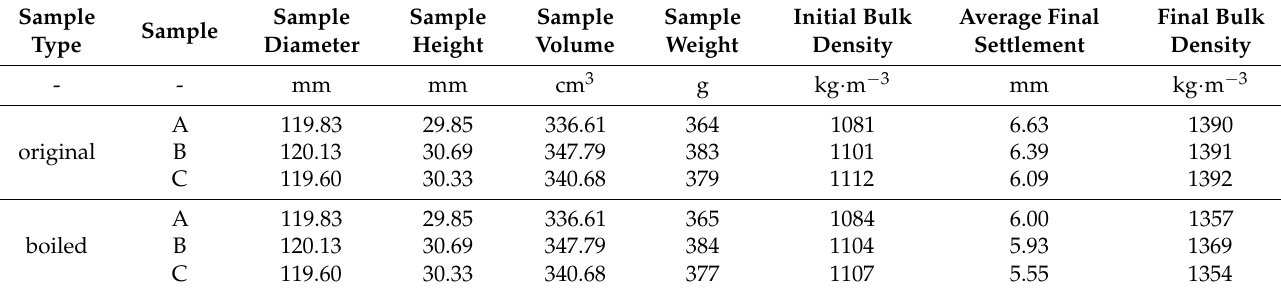
Table 4. Parameters of oedometer tests.